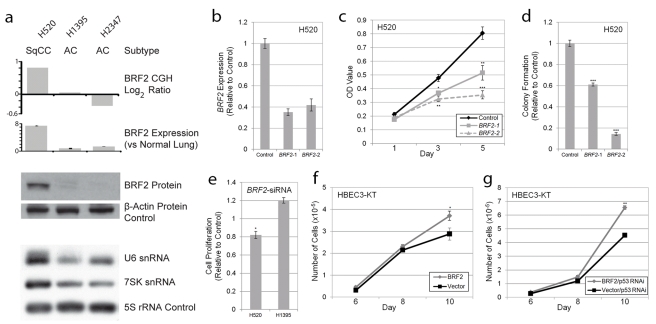
BRF2 activation contributes to cell growth and proliferation.(A) Concordance between BRF2 copy number (array CGH), expression (qRT-PCR), protein (immunoblot) levels, and Pol III transcript levels (northern blot) in H520, H1395, and H2347 NSCLC cell lines. (B) Decrease in BRF2 mRNA levels in H520 cells expressing shRNAs targeting BRF2 relative to those expressing a negative vector control (mean ± SEM of triplicate samples). (C) BRF2 knockdown results in decreased cell proliferation in H520 cells with amplification and overexpression as measured by MTT assay relative to vector control (mean ± SEM of triplicate samples). (D) BRF2 knockdown reduces colony growth of H520 cells in soft-agar relative to vector control (mean ± SEM of triplicate samples). (E) siRNA transfection results in decreased cell proliferation as measured by the MTT assay in H520 SqCC cells but not H1395 AC cells relative to nontargeting siRNA control (mean ± SEM of triplicate experiments). Increased saturation density in both (F) BRF2 expressing HBEC and (G) BRF2 and p53RNAi expressing HBEC compared to their respective controls (mean ± SEM of triplicate samples). *, p<0.05; **, p<0.01; ***, p<0.001 (Student's t test; compared to control).